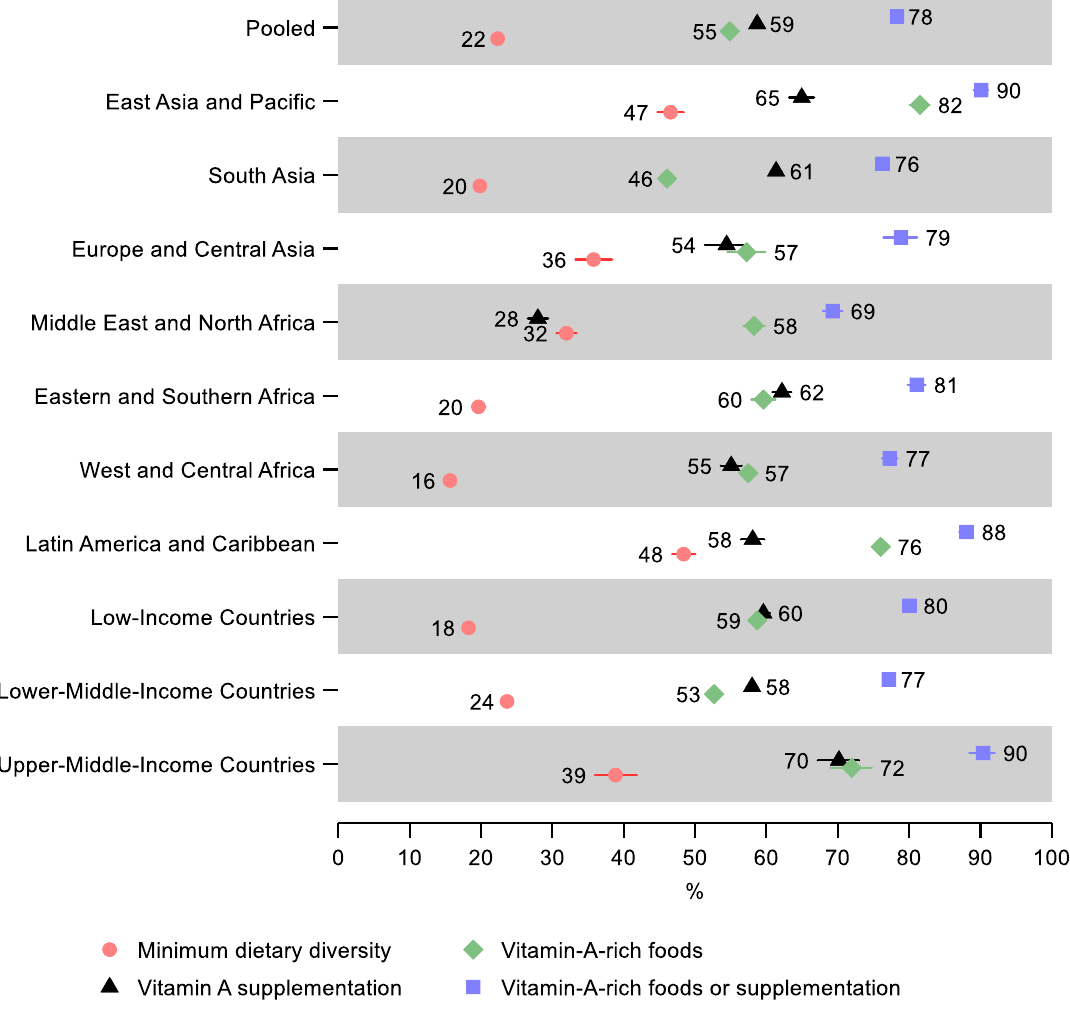
Figure 1. Percentage of children 6–23 months old that received the minimum dietary diversity, vitamin-A-rich foods, vitamin A supplementation, and either vitamin-A-rich foods or vitamin A supplementation in low- and middle-income countries. Notes: 95% confidence intervals are shown. Some confidence intervals may be narrower than the symbol for the estimate and therefore not visible. See Table S4 in the Supplement for the tabulated estimates and confidence intervals.